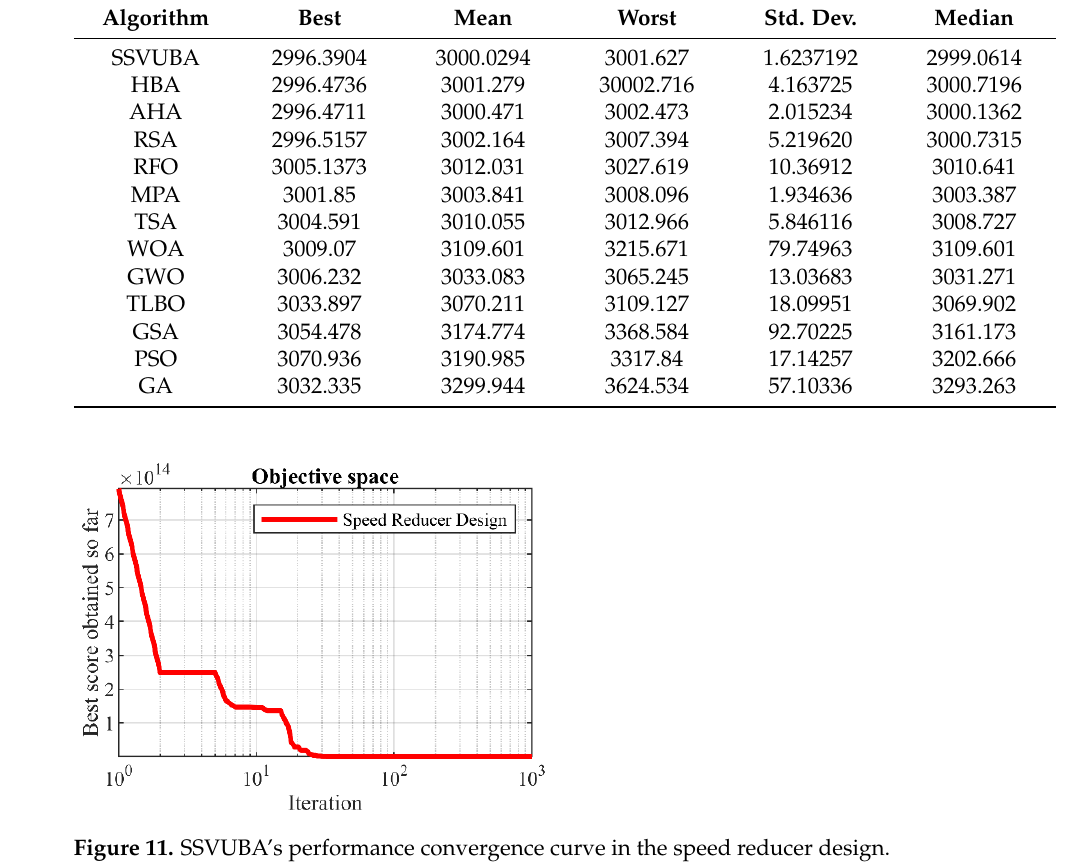
Table 13. Statistical results of optimization algorithms for the speed reducer design problem.